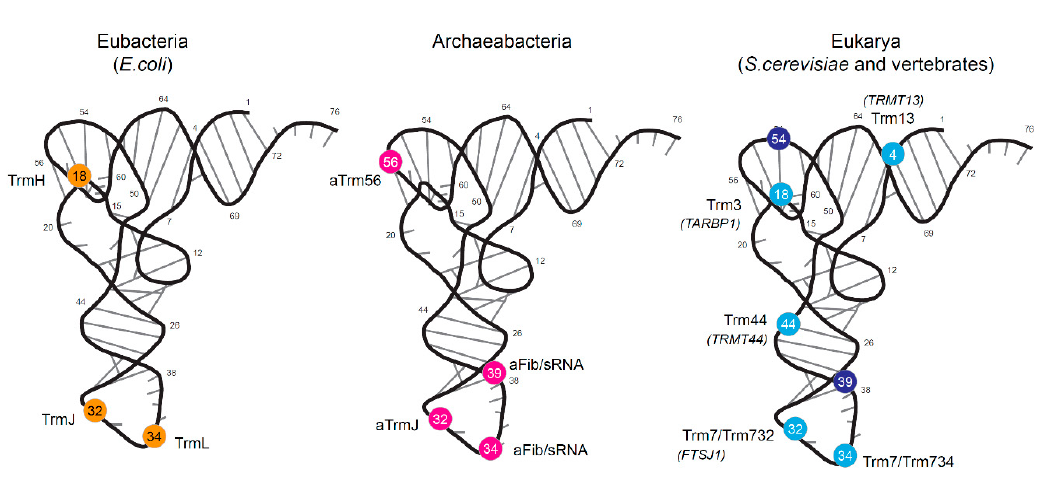
Figure 1. Known positions of tRNA 2 ′ ‐ O ‐ methylations and corresponding enzymes in Eubacteria ( E. coli / Bacillus subtilis ), Archaea (data almost exclusively from H. volcanii ) and Eukarya ( S. cerevisiae and various vertebrates). tRNAs are represented in folded 3D structures. 2 ′ ‐ O ‐ methylated nucleotides are shown as spheres, orange for Eubacteria, pink for Archaea. Light blue color corresponds to yeast modifications; additional vertebrate positions are shown in dark blue. Names of homologous human proteins are in